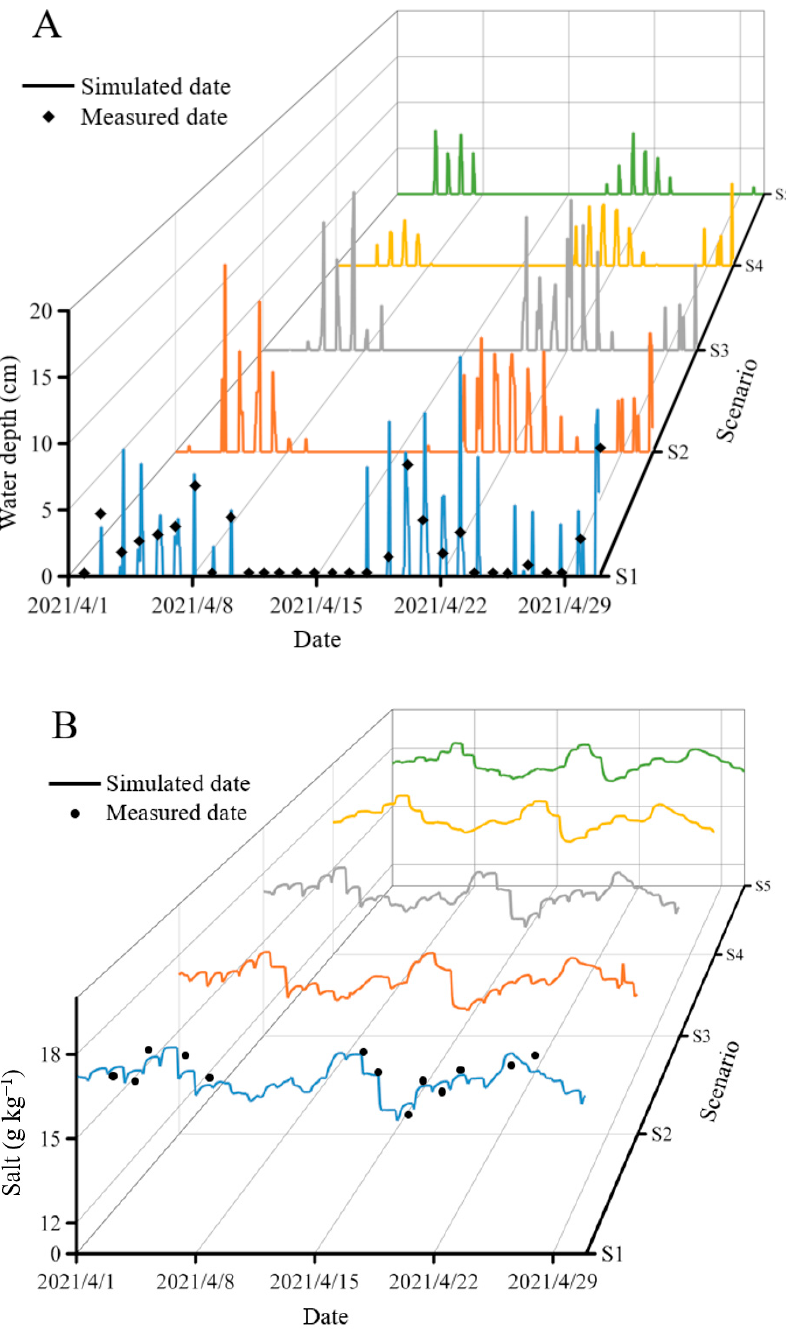
Figure 5. Water depth ( A ) and water salt content ( B ) variations in the reconstruction area of each scenario.